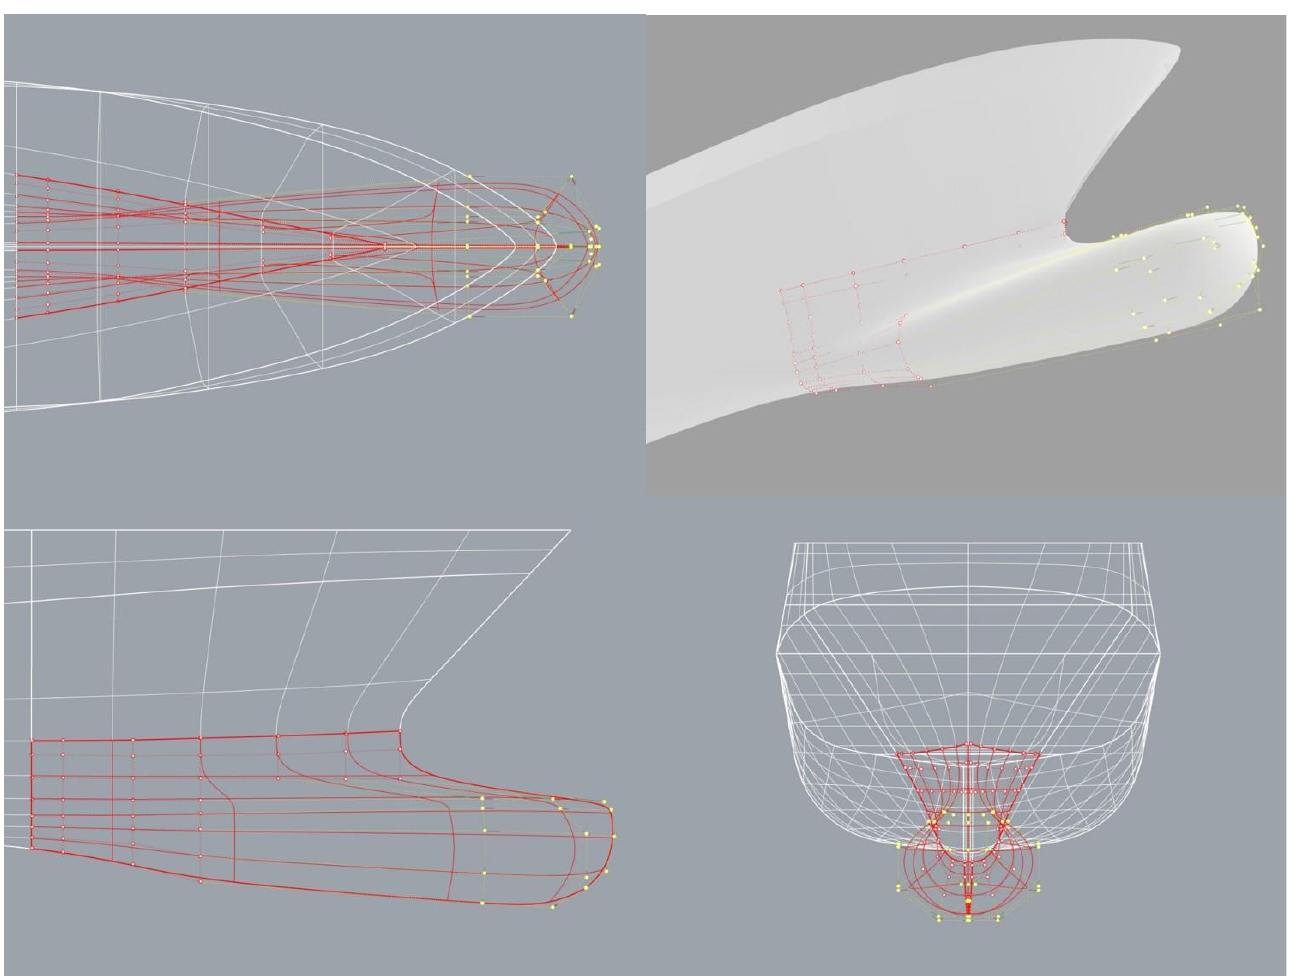
Figure 4. The details of the distribution of the control points around the optimal sonar dome, i.e., F0.225. The white and red lines are the surface outlines of the ship’s hull and sonar dome, respectively. The red hollow points are the control points on the sonar dome. The yellow hollow points are selected to protrude the dome geometry.